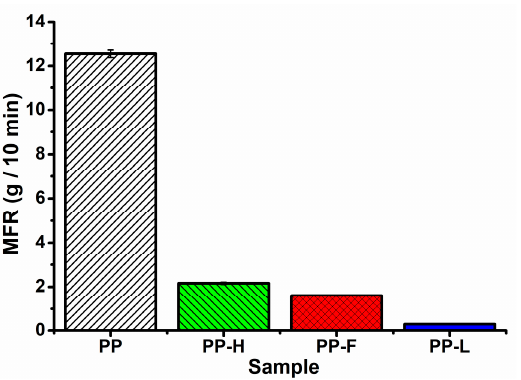
Figure 9. Melt flow rate of neat PP and composites reinforced with hemp, flax and Lyocell fibres.